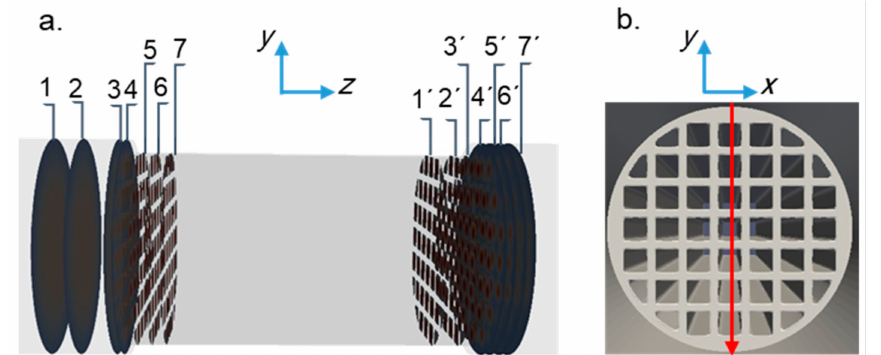
Figure 10. ( a ) The axial position of the investigated slices analyzed for upstream and downstream flow. ( b ) The arbitrary line over the cross-sectional slices used for plotting radial velocity profiles in Figure